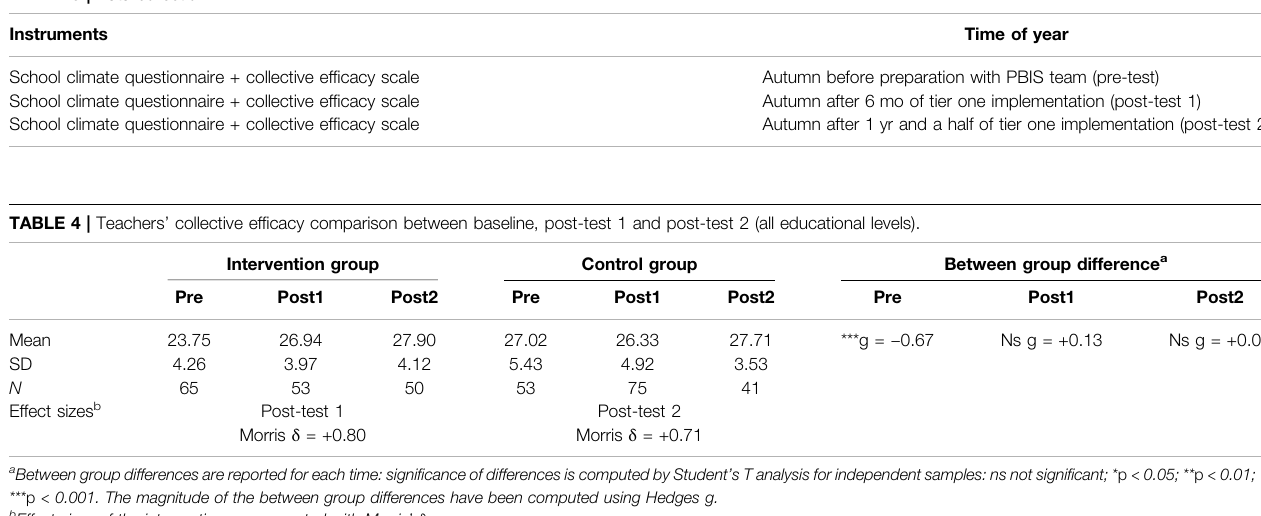
TABLE 3 | Data collection.